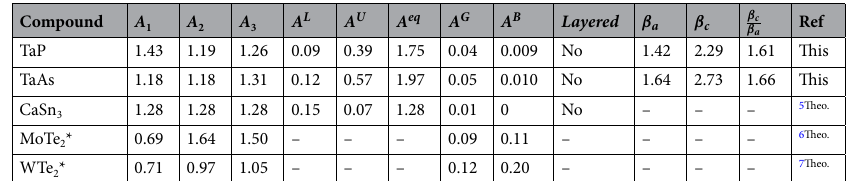
MoTe 2 * 0.69 1.64 1.50